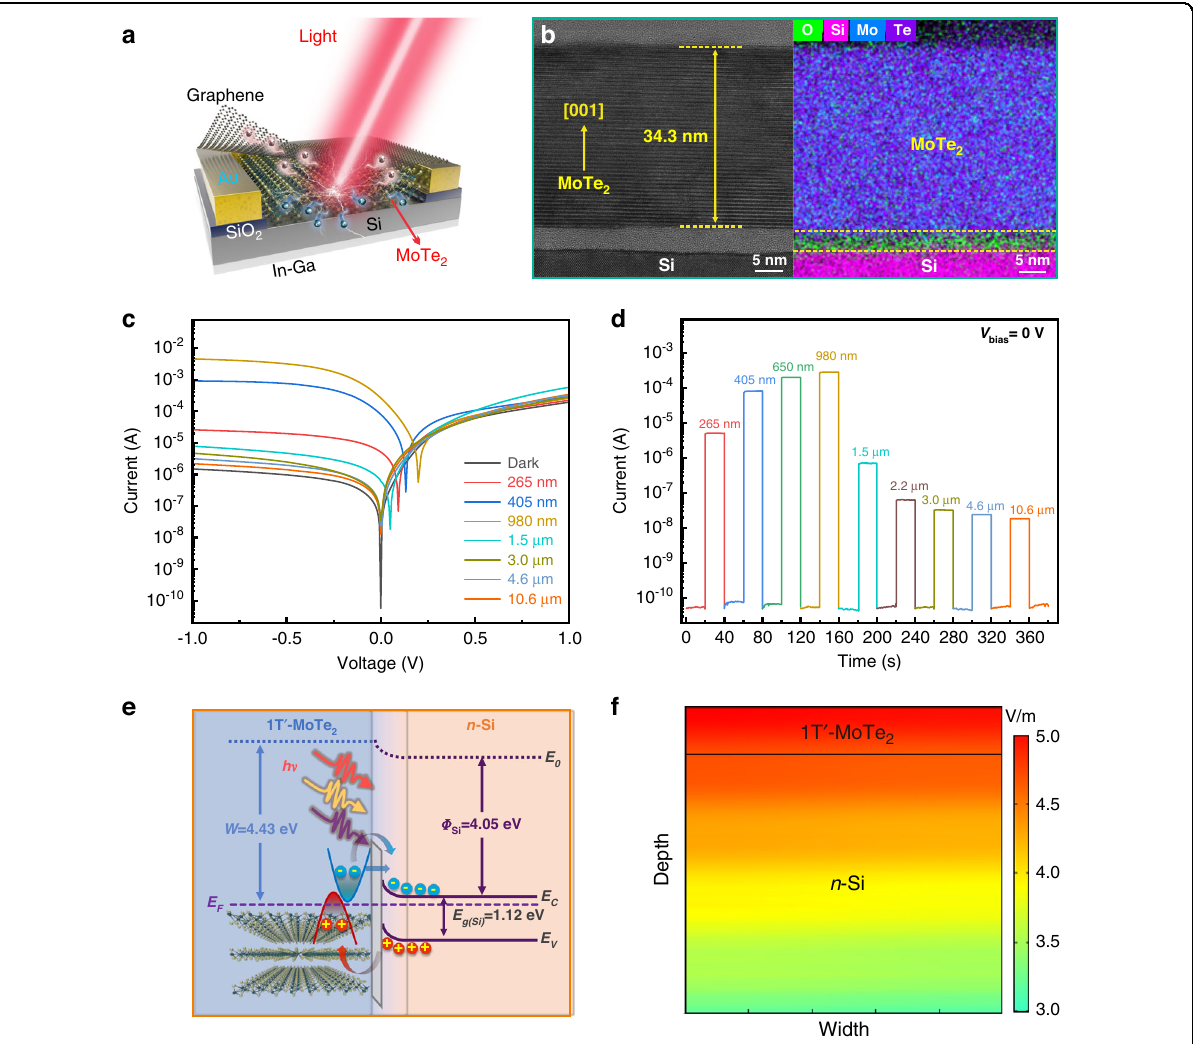
Fig. 3 Optoelectronic performance of the photodetector. a Schematic illustration of a graphene/1T ʹ -MoTe 2 /Si Schottky junction device. b Cross- sectional HRTEM image of the device and the corresponding elemental mapping image. c I-V characteristics of the graphene/1T ʹ -MoTe 2 /Si Schottky junction device acquired in the dark and under irradiation of broadband light. d Time-dependent photoresponse properties to pulsed light illumination in a broad spectral band. e , f Energy band diagram and electrical potential distribution of the